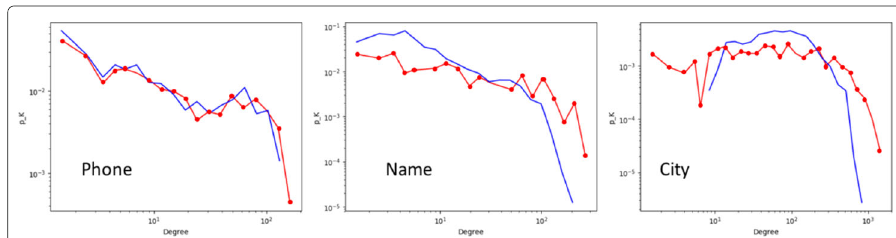
Fig. 3 (Log-log) Degree distributions of Set 2 (Dotted Red) and Set 8 (Solid Blue) extraction networks for all three attributes. The Y-axis records the empirical probability of each degree value